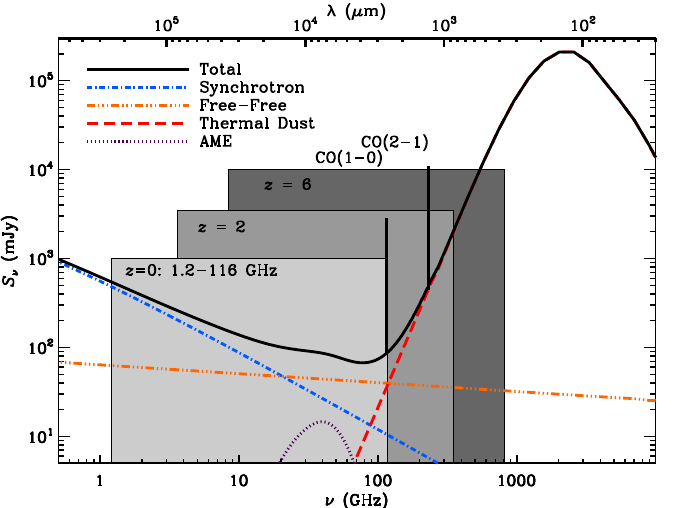
Figure 1. A model radio-to-infrared spectrum for a star-forming galaxy, showing that observations at frequencies spanning 1.2–116GHz provide direct access to free-free emission, whose contribution increases with frequency, and thus with the rest-frame emission from high-z galaxies (highlighted for z ∼ 2 and z ∼